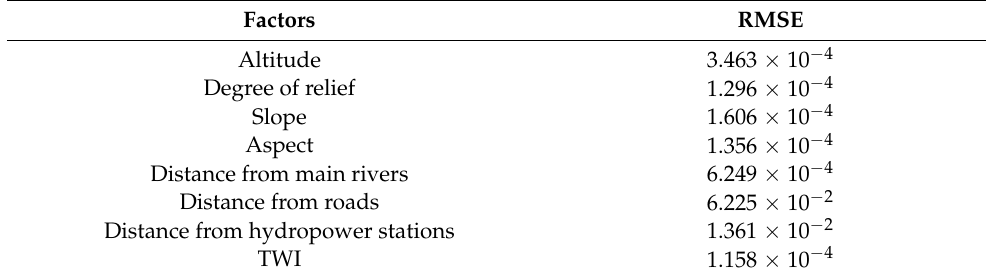
Table 3. Root Mean Squared Error (RMSE) of GPR regression results.